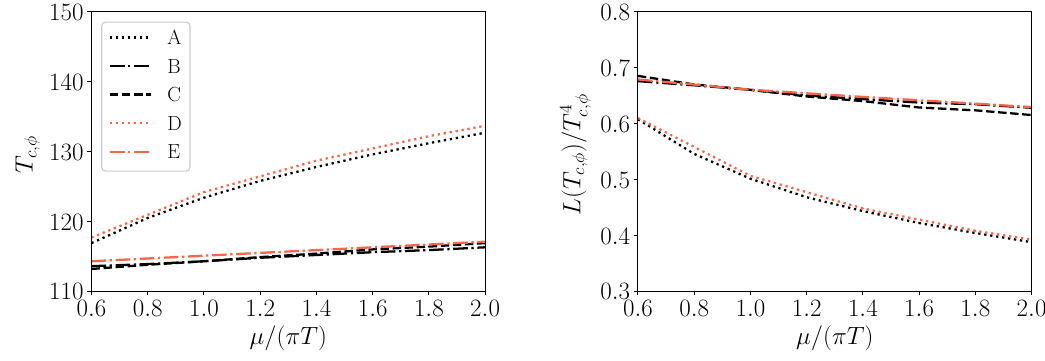
Figure 4 . Left: T c ,φ as function of the 4d renormalisation scale µ in different approximations (A–E) that are detailed in the main body. The gauge-invariant ~ -expansion (black lines A–C) and the analysis based on direct numerical minimisation of the effective potential in Landau gauge (red lines D, E) show minor difference in the sensitivity to µ . Right: as left panel, but for the latent heat evaluated at T c ,φ . Key results: two-loop thermal masses (B, E, C) drastically reduce renormalization scale dependence. The latter poses a significantly larger source of numerical error than gauge dependence (E). The one-loop computation within the 3d EFT performs well (C), provided two-loop thermal masses are